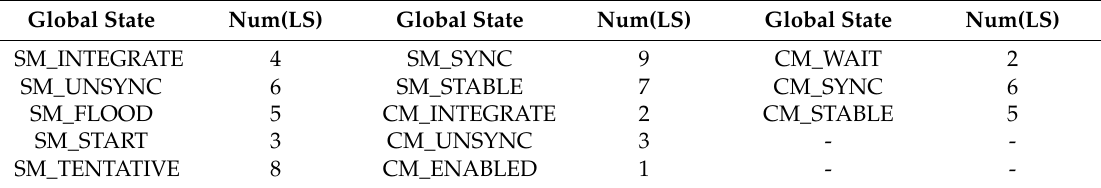
Table 2. The number of local states (LS) corresponding to the global state in the AS6802 IP